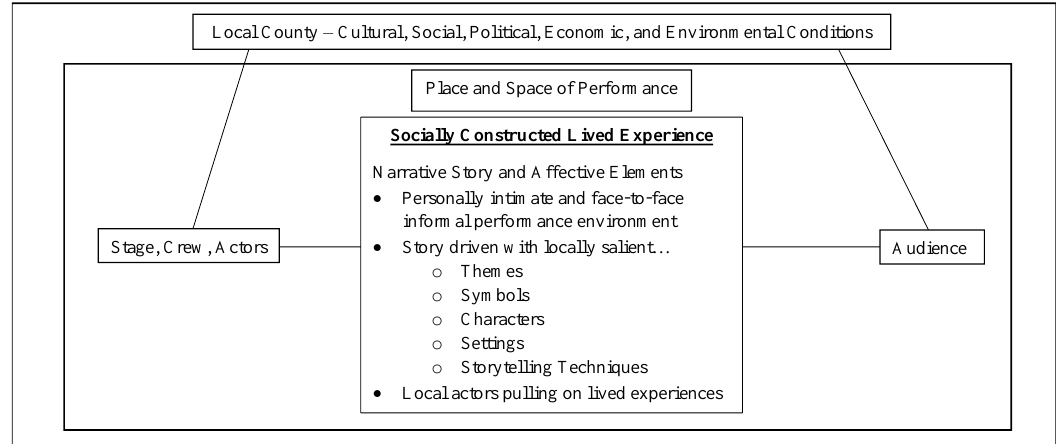
Figure 2. The Hall of Local Mirrors and Meanings.